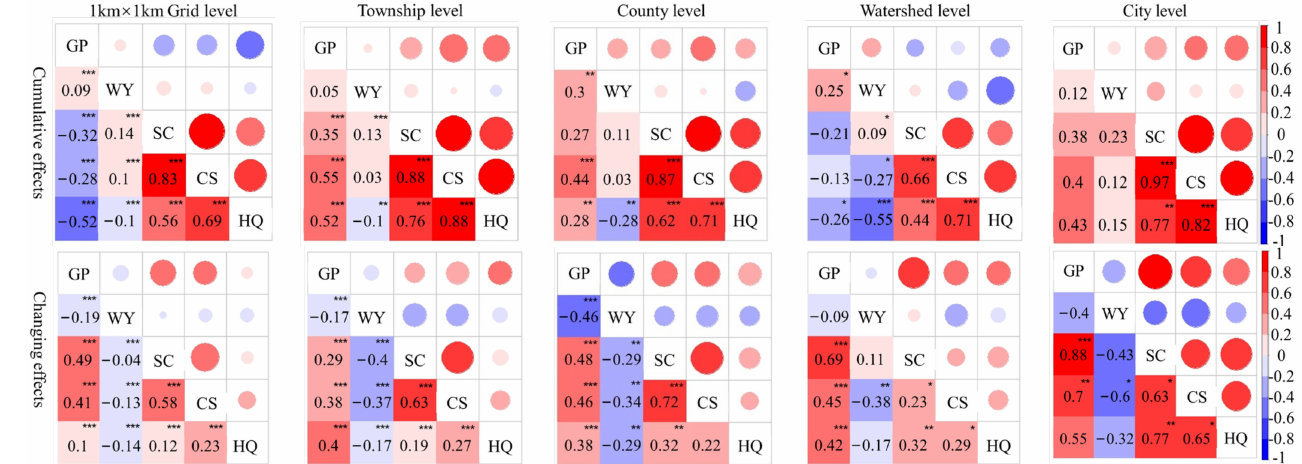
Figure 2. Relationship of the cumulative and changing effect among ecosystem services at different scales (1 km × 1 km grid level, township level, county level, watershed level, and city level) in the Pearl River Delta. Note: *, **, and *** denote significance at 0.1, 0.05, and 0.01 probability levels,